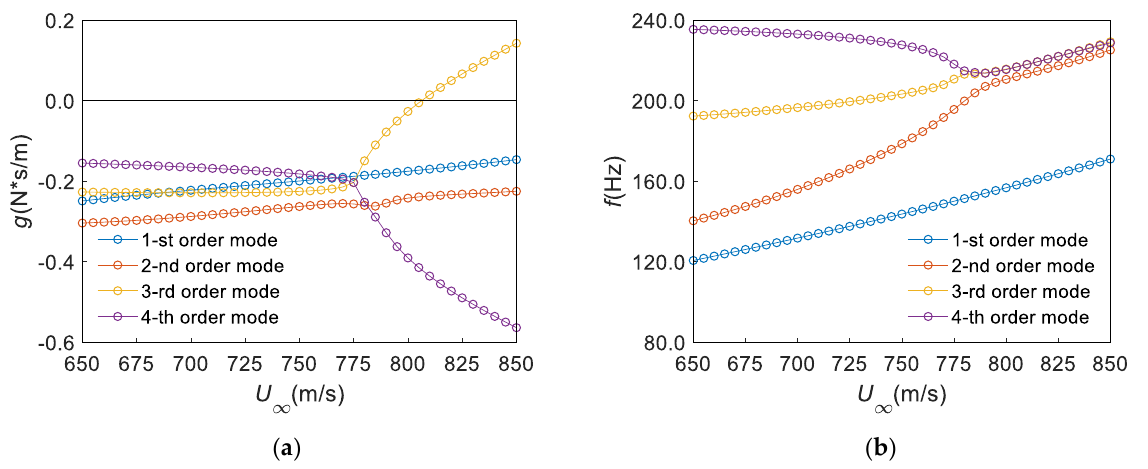
Figure 23. Results of flutter calculation for the panel with the 9P method damper configuration ( Ma ∞ = 2.0): ( a ) U − g (AR1), ( b ) U − f